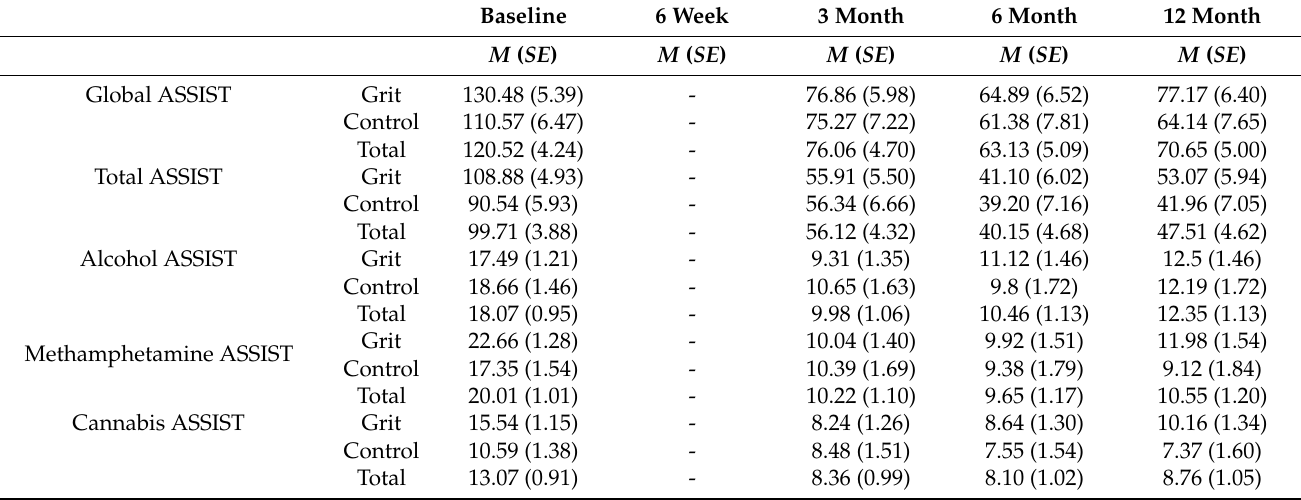
Table 3. Outcome Measures at Baseline and at 6 week, 3-, 6-, 12-month follow-ups.